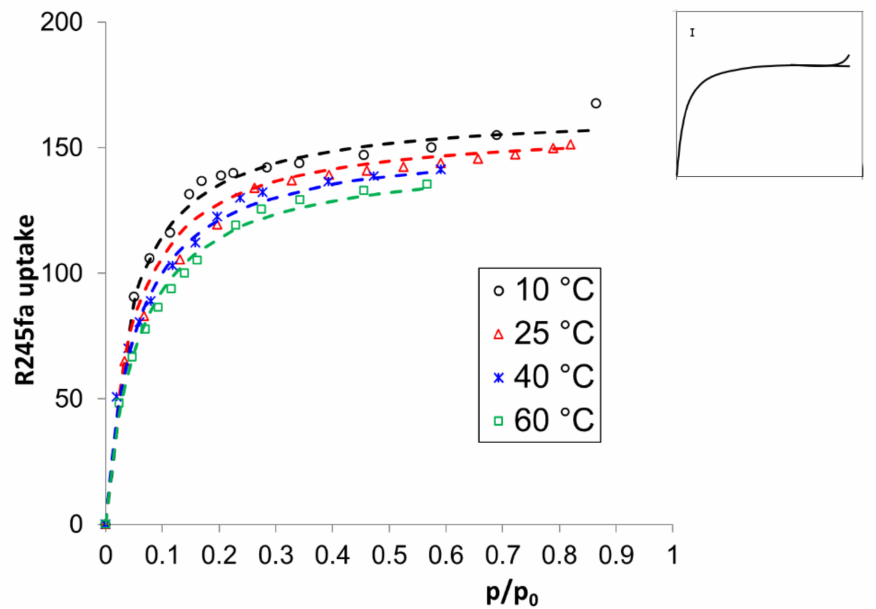
Figure 4. R245fa mass uptake by weight of MIL101 [%] as a function of the relative pressure for four temperature values. Experimental data (coloured circles) and fitting Langmuir model